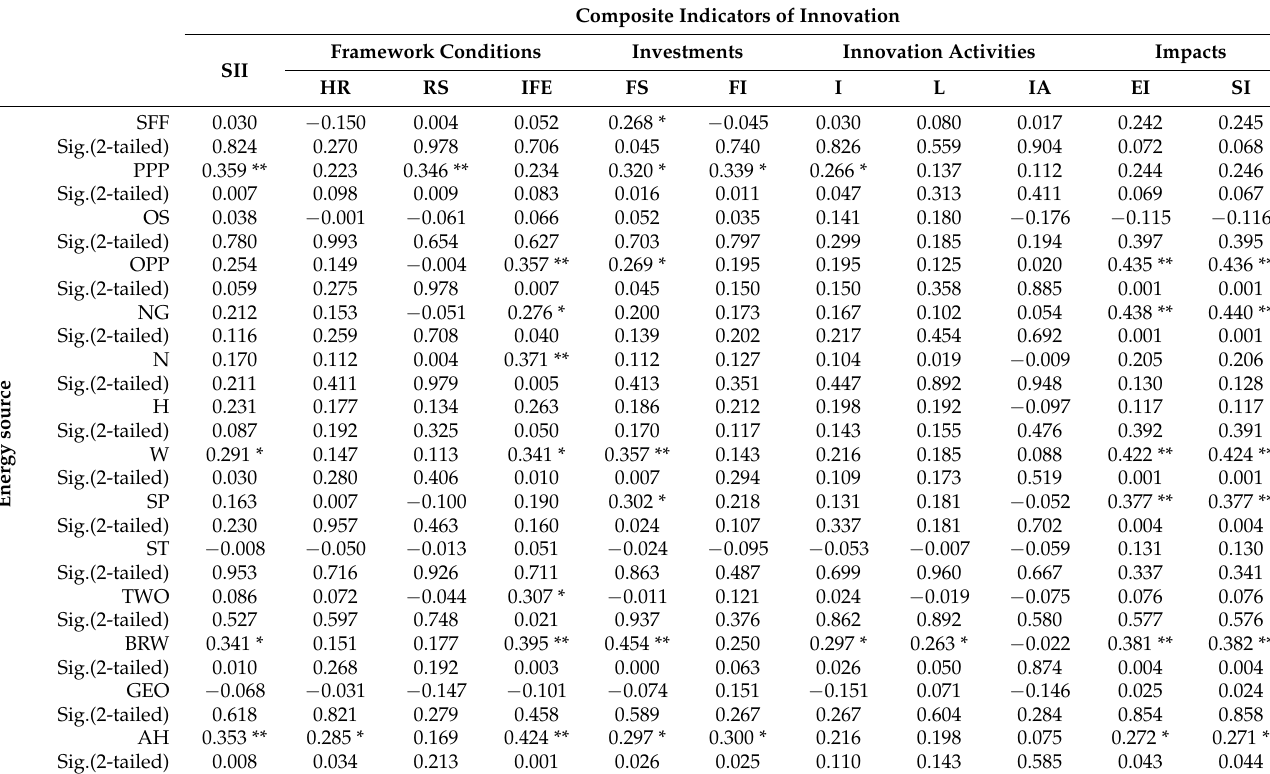
Table 9. Energy consumption by source vs. innovativeness indicators in EU countries—correlation matrix (Pearson’s correlation